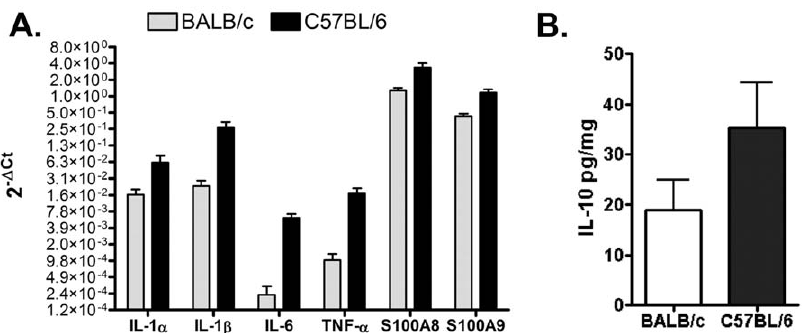
Figure 5. Profiling of placental inflammatory mediators in sham inoculated BALB/c and C57BL/6 mice. ( A) Normalized gene expression values are expressed as 2 2 D Ct [72]. (B) Production of IL-10 expressed as mean (pg/gm weight of tissue) 6 SD. Values represent 5 biological replicates from 3 independent experiments.